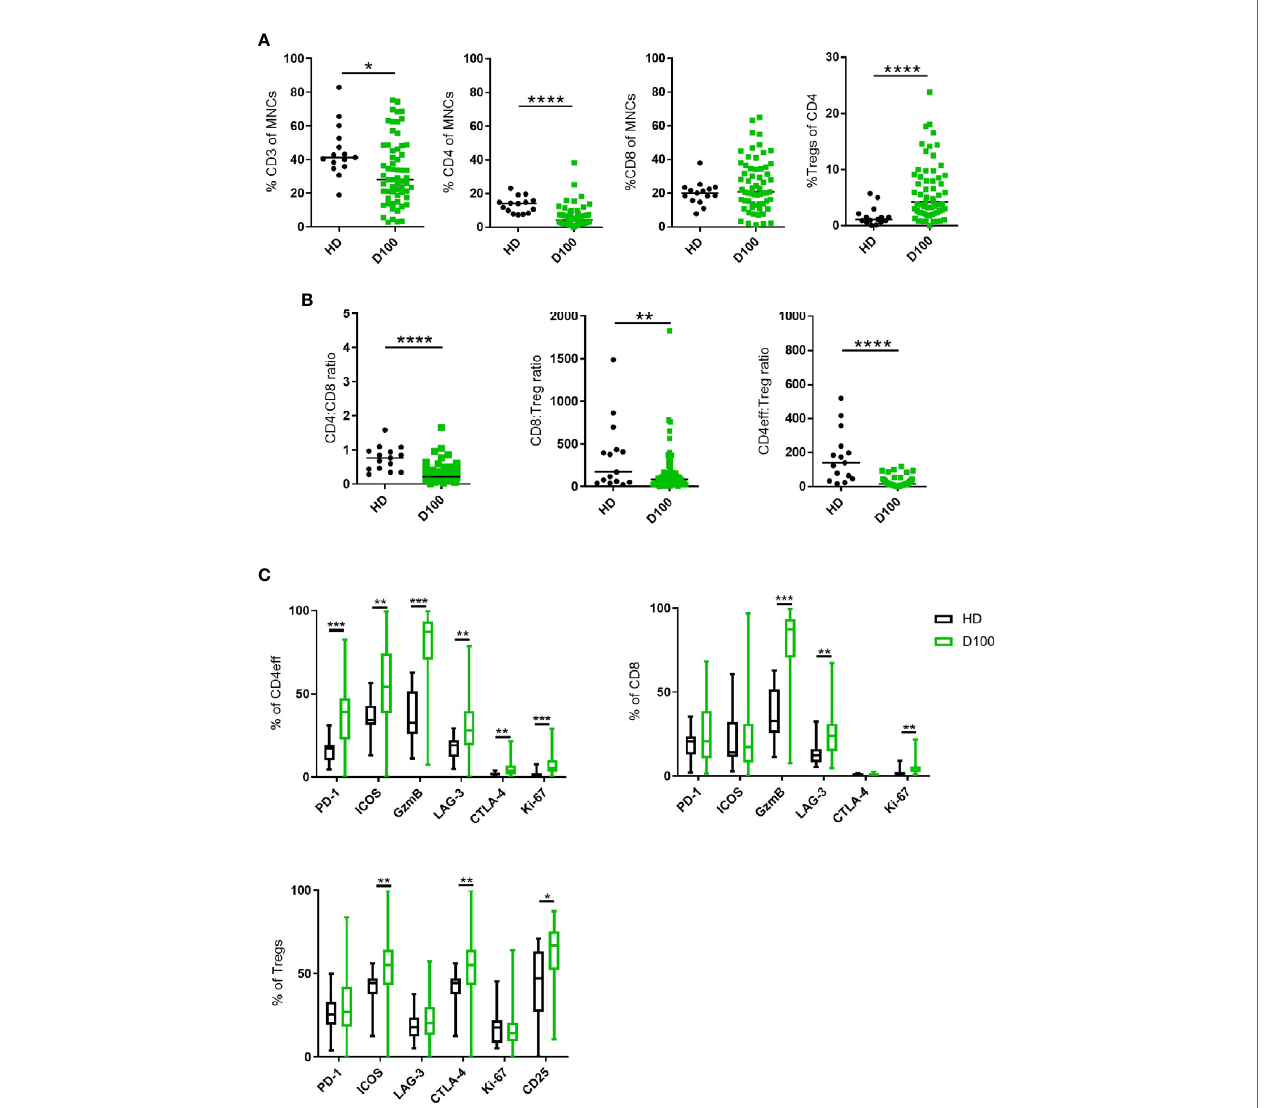
FIGURE 1 | T cell subsets in MM BM post-ASCT. (A) Frequency of CD3, total CD4, CD8 T cells and Tregs. (B) CD4:CD8 and effector:Treg ratios calculated using absolute numbers of populations in each sample. (C) Frequency of markers of immune regulation, activation and proliferation on CD4eff, CD8, and Tregs. N=61. Statistical analysis by using Mann-Whitney U test *p < 0.05, **p < 0.01, ***p < 0.001. Lines indicate median for (A, B) . Box & whisker plots, (C)